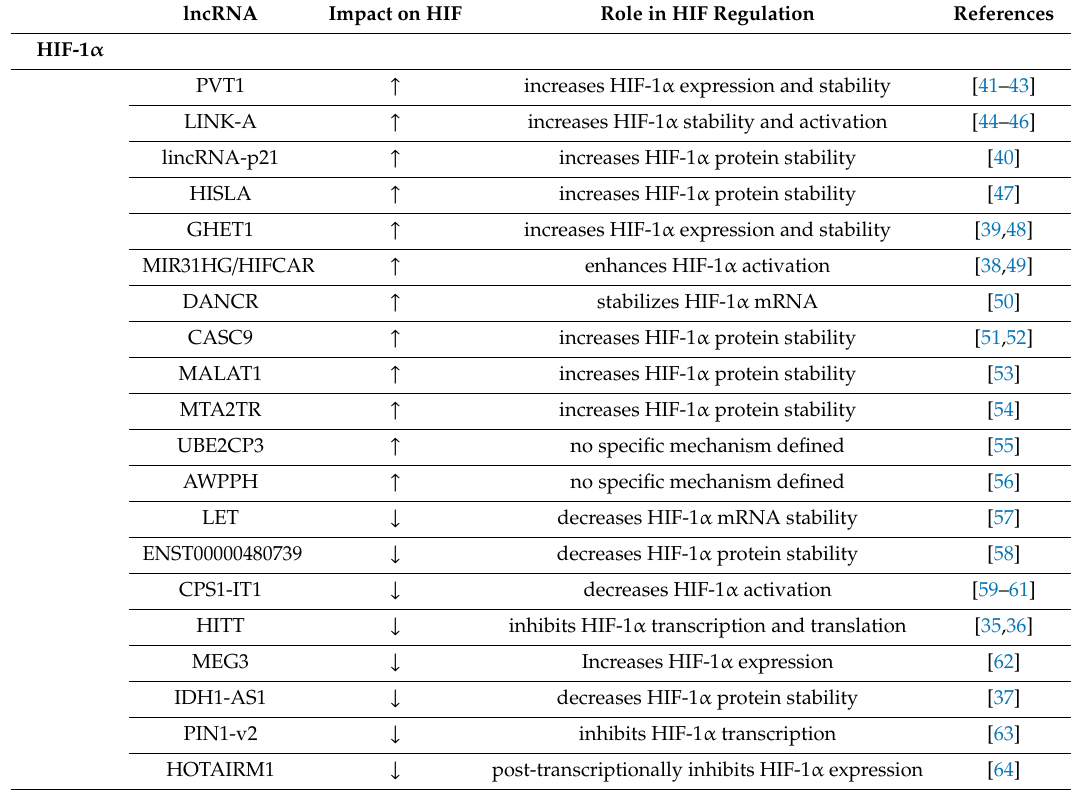
Figure 1. Regulation of hypoxia-inducible factor (HIF) and examples of long non-coding RNA (lncRNA) involvement. After transcription and translation under normoxic conditions hypoxia-inducible factor (HIF) 1/2 α is hydroxylated by proline hydroxylases (PHD) which subsequently enables binding of the von Hippel-Lindau (VHL) protein and results in VHL-mediated ubiquitination and degradation through the proteasome pathway. In hypoxia, PHDs are inhibited and HIF-1/2 α accumulate and are activated by dimerization with the constitutively expressed HIF-1 β leading to transcription of HIF target gene. lncRNAs are involved in HIF regulation in several ways. For instance, they may regulate HIF transcription and translation, act as microRNA sponges, directly bind to PHDs and VHL or facilitate binding between HIF and transcriptional cofactors. (Created with BioRender.com). Table 1. Overview of long non-coding RNAs involved in HIFs regulation, not including competing endogenous